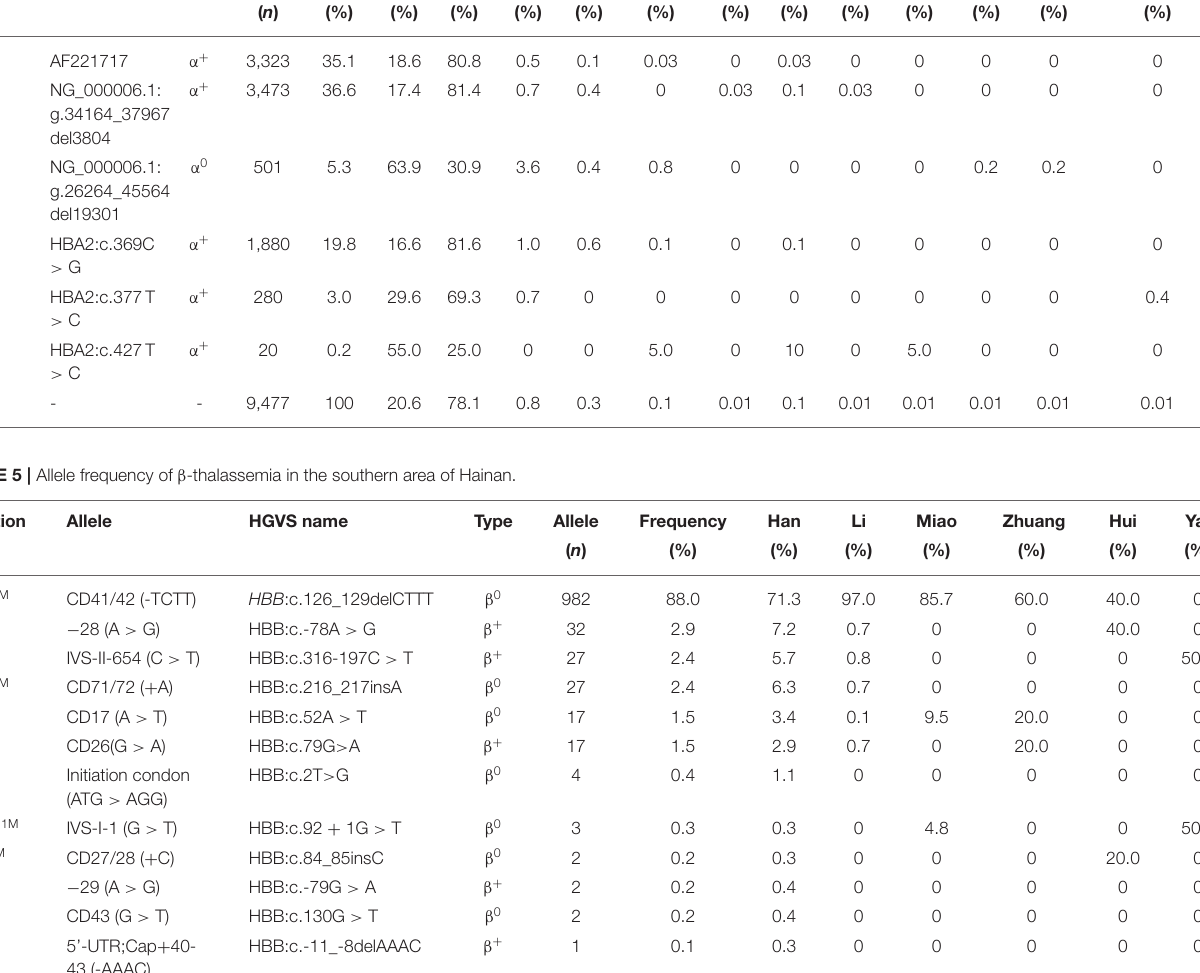
TABLE 4 | Allele frequency of α -thalassemia in the southern area of Hainan. Mutation HGVS name